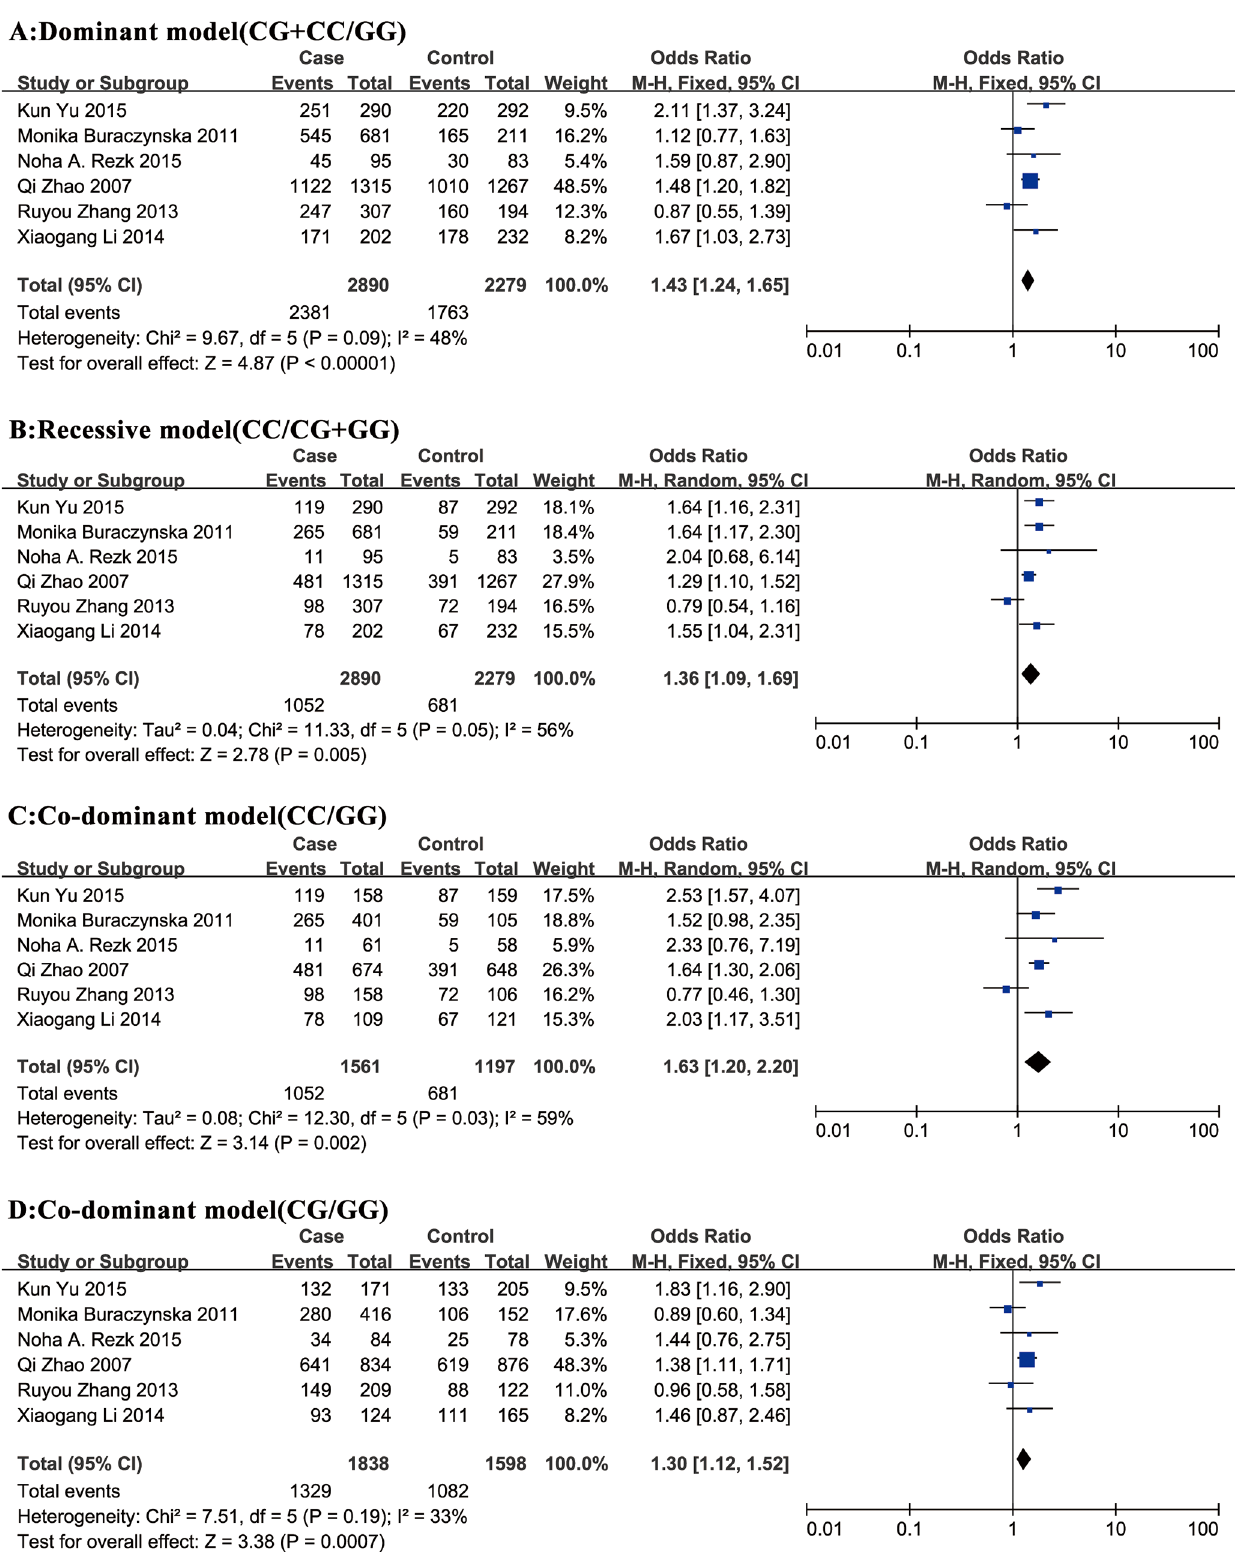
Fig 3. Forest plots of the association between rs2296545 and risk of HT in the dominant, recessive, and codominant models. Case events indicate hypertensive subjects; Control events indicate normotensive subjects. doi:10.1371/journal.pone.0158880.g003 PLOS ONE | DOI:10.1371/journal.pone.0158880 July 19,